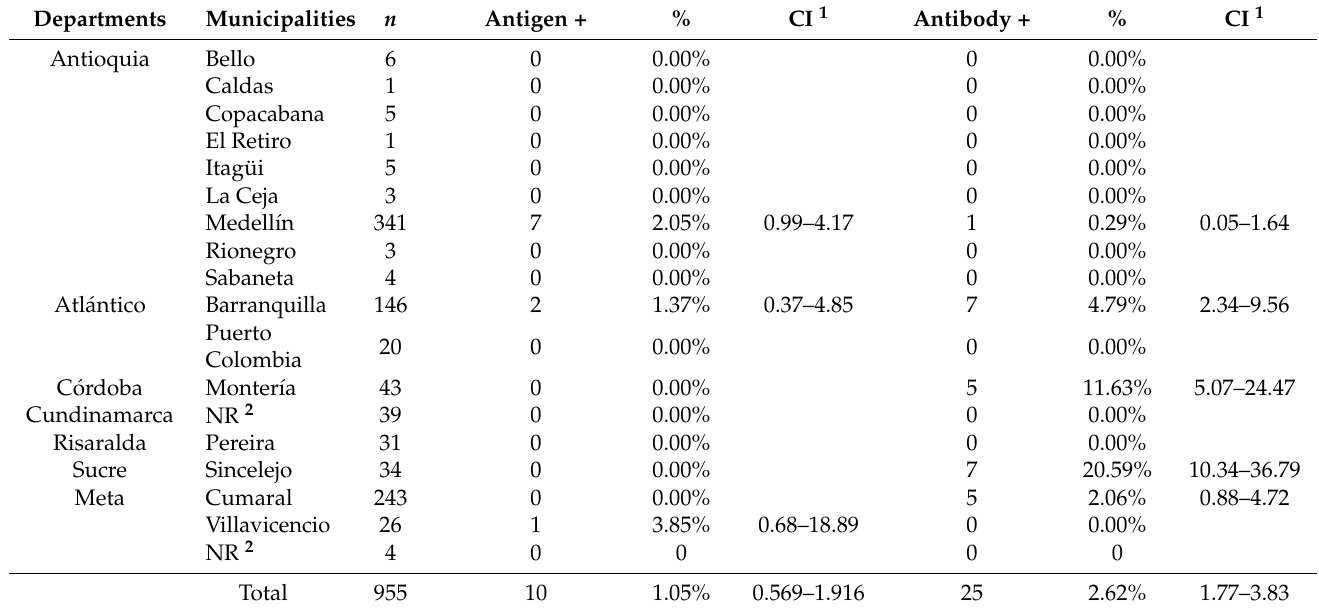
Table 1. Serological results of dog sera samples from Colombia, tested for the presence of A. vasorum antigens and for specific antibodies against A. vasorum